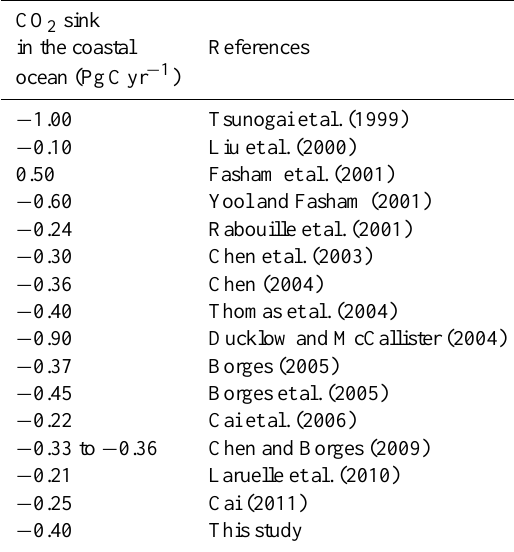
Table 7. Summary of reported annual global air–sea CO 2 fluxes in the world’s continental shelves.